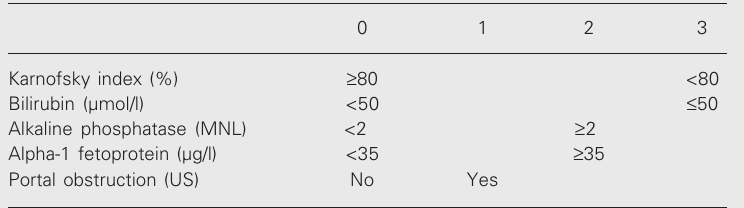
Table 4. French classification of hepatocellular carcinomas (31).